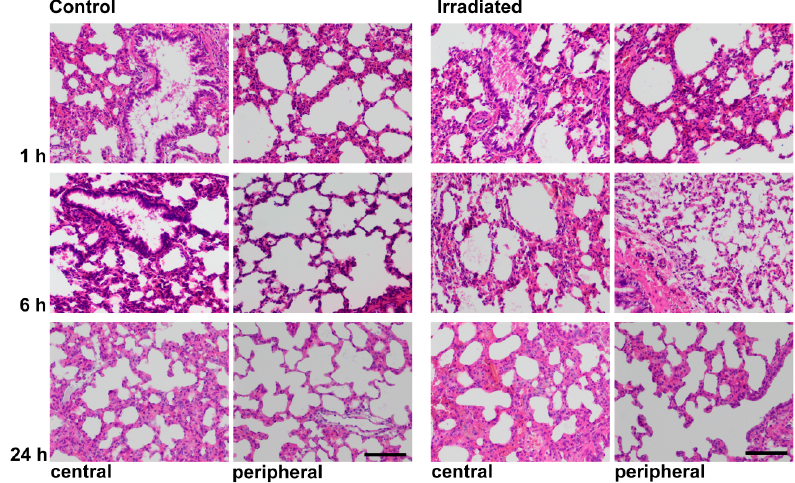
Figure 3. Hematoxylin-eosin staining of central and peripheral areas of the lung at 1, 6 and 24 h of sham irradiated rats (control) and after single-dose irradiation with 25 Gy (original magnification 200×, scale bar = 100 μ m).